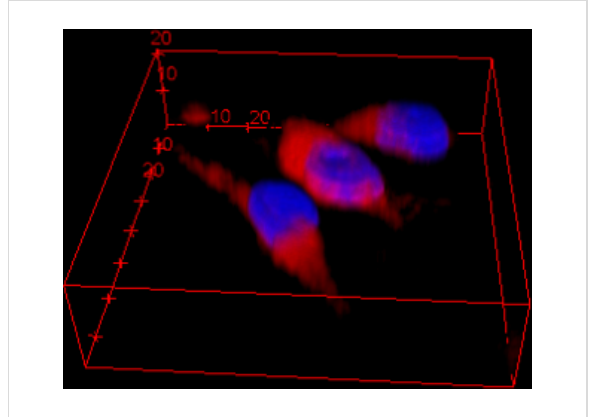
Figure 9: Three-dimensional reconstruction by confocal microscopy of cells incubated for 12 h with 20 µg mL − 1 of fluo-CNOs in DMEM, and then for 1 h in acidic PBS (pH 4.5) and stained with Hoechst